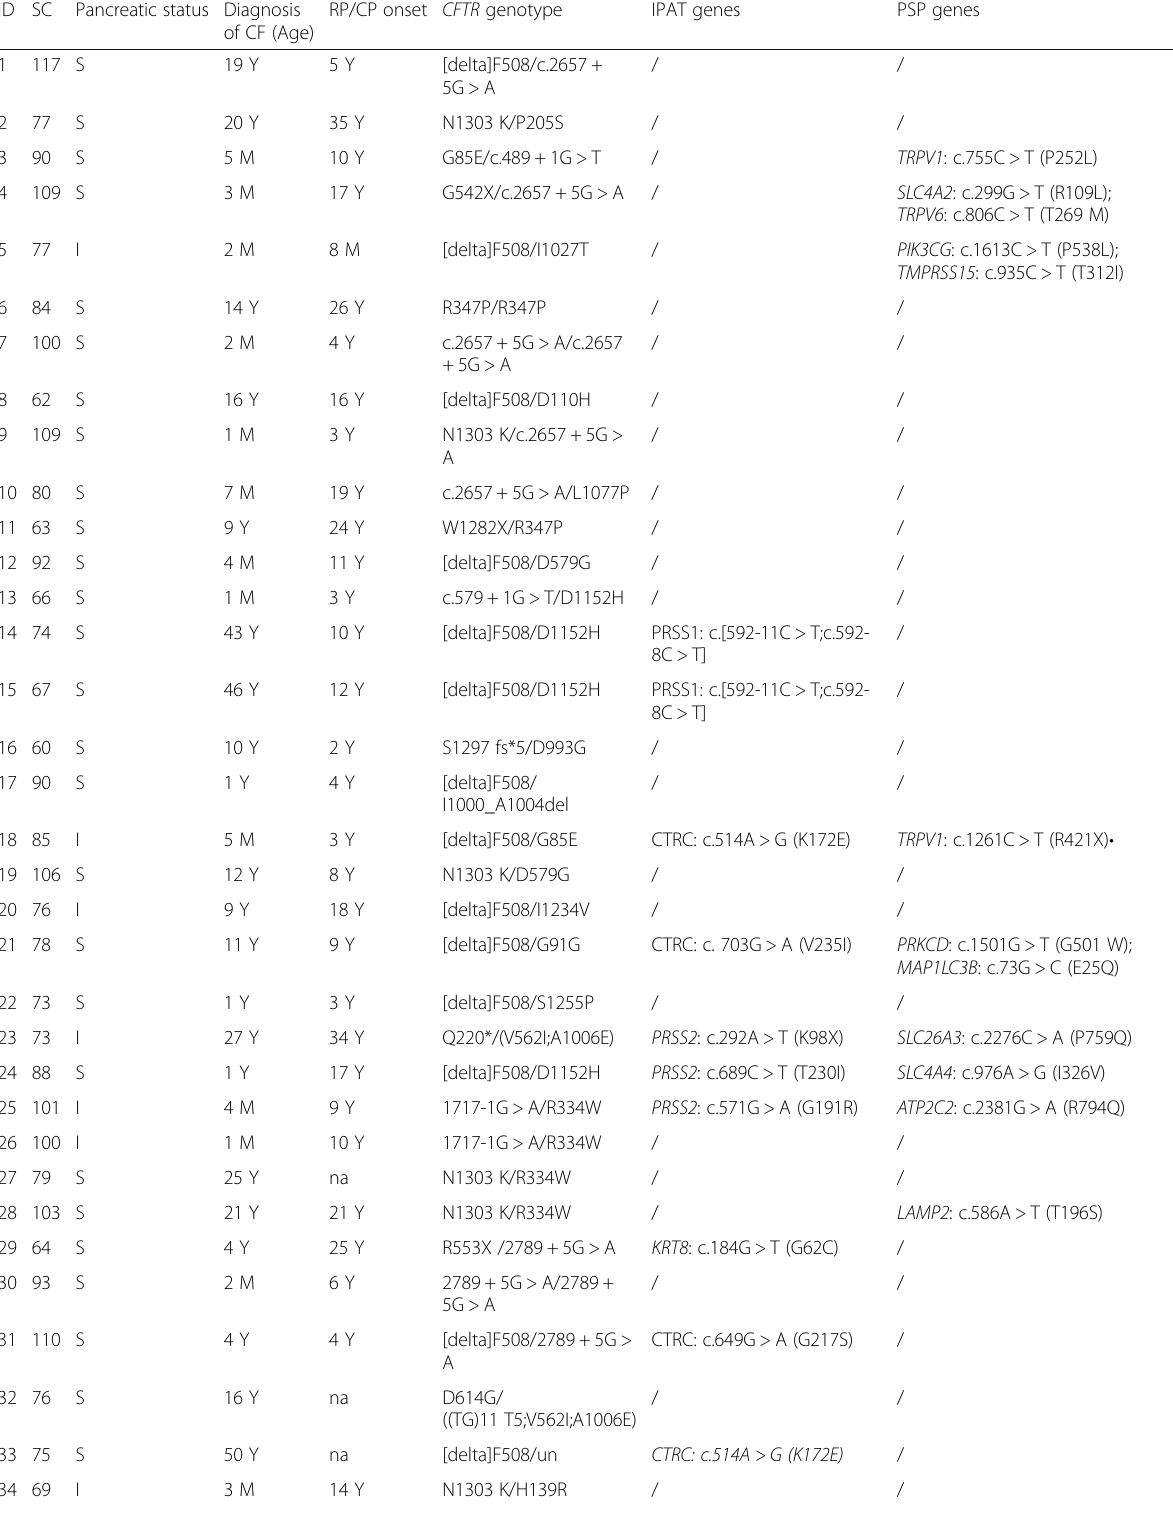
Table 2 Sweat chloride (mmol/L, SC), pancreatic status, age at CF and pancreatitis diagnosis, CFTR genotype and mutations in genes related to intra-pancreatic activation of trypsin (IPAT) and pancreatic secretion pathway (PSP) genes in 48 patients with CF and recurrent/chronic